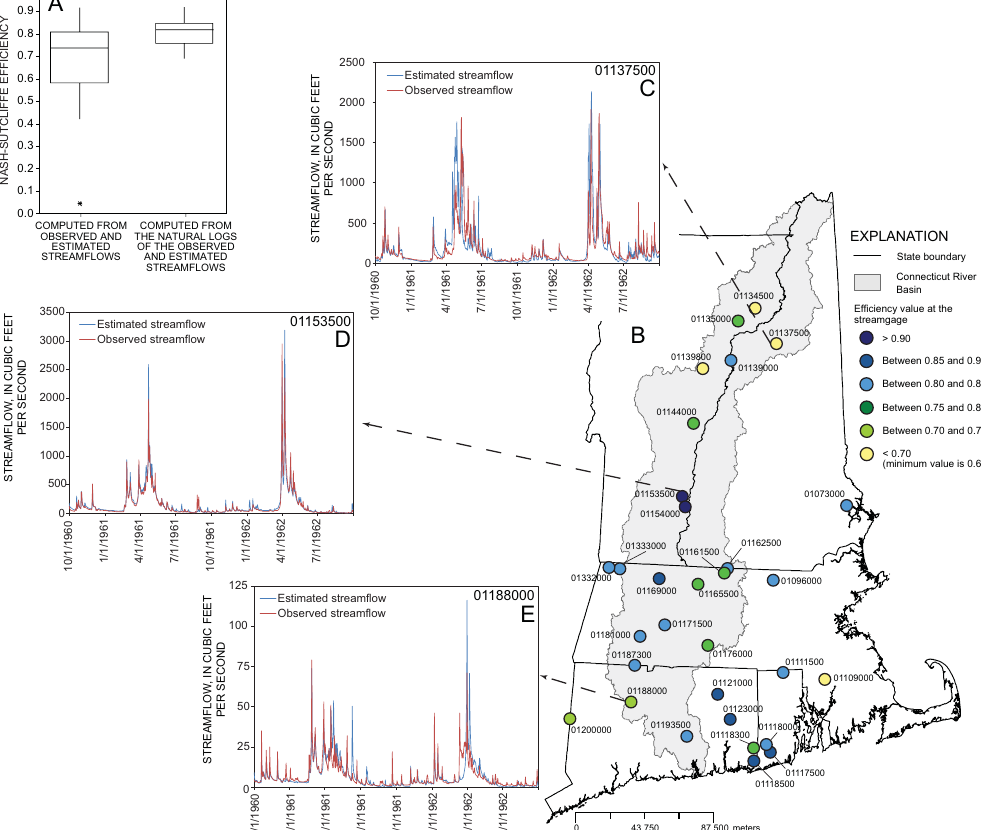
Fig. 6. Range of efficiency values computed between the observed and estimated streamflows at the 31 validation streamgauges (A) , spatial distribution of efficiency values resulting from log-transformed observed and estimated daily streamflow at 31 validation streamgauges (B) and selected hydrographs of observed and estimated streamflow for the period from 1 October 1960 through 30 September 1962 (C–E) . The boxplot (A) shows the median, interquartile ranges and the upper and lower limits (defined as 75th percentile 1.5 ∗ (75th percentile–25th percentile)). Values outside of the upper and lower limits are shown as an